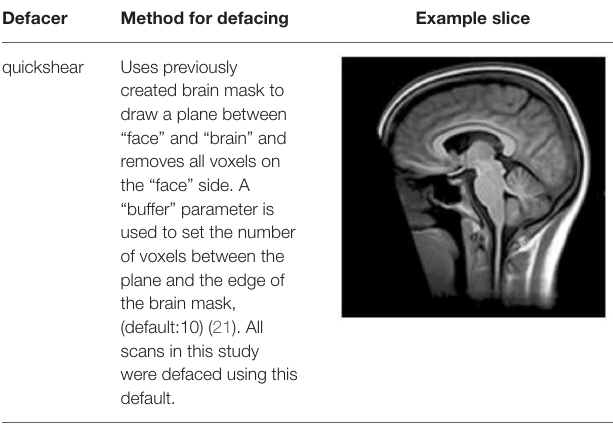
Defacer Method for defacing Example slice